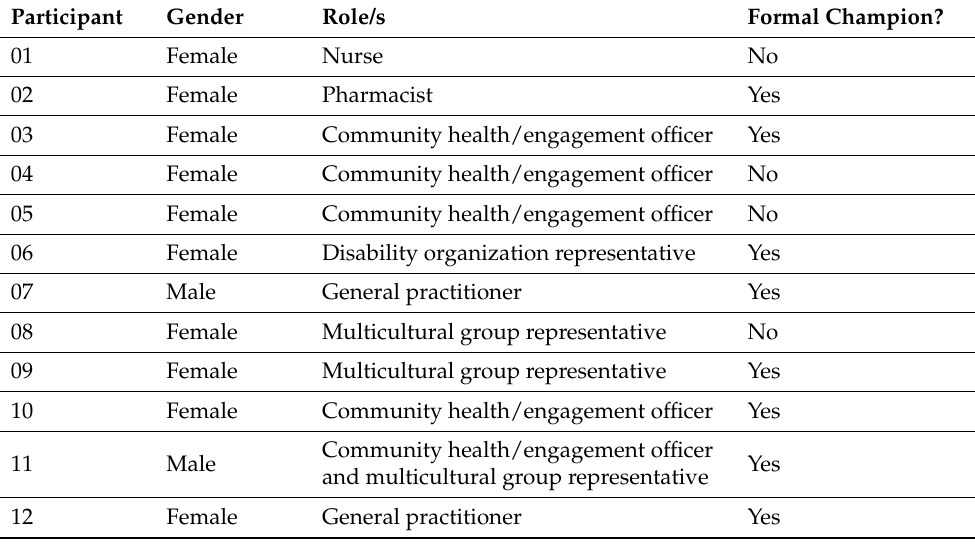
Table 1. Characteristics of interview